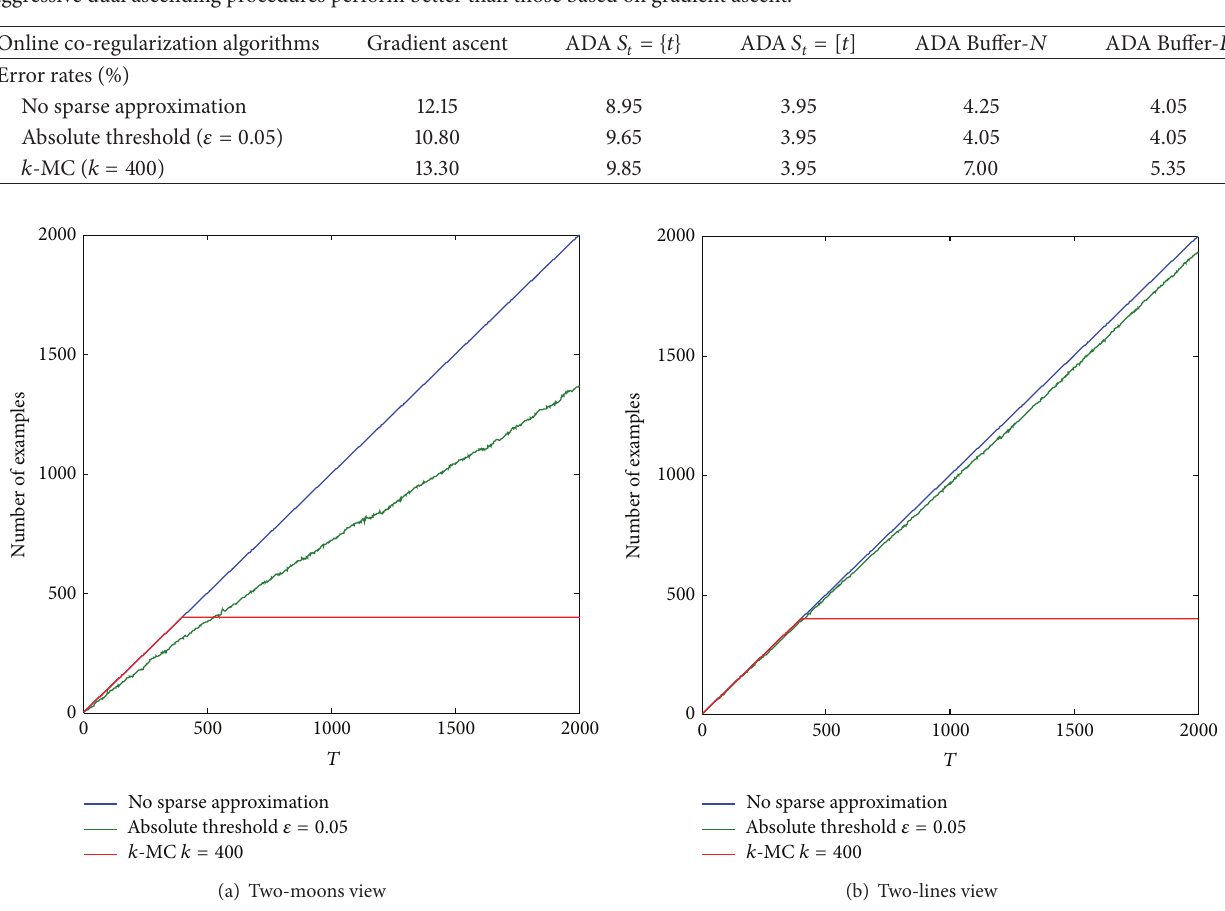
Figure 5: The number of examples in the kernel representation of boundary vectors in two views for different sparse approximation approaches. The online coregularization algorithm used in this experiment is ADA (Buffer- 𝑁 ). If no sparse representation approaches are used, the kernel representation contains all the arrived examples on each learning round. The number of examples in the kernel representation increases slowly while using an absolute threshold, and the number is at most 𝑘 while using 𝑘 -MC for online coregularization algorithms.